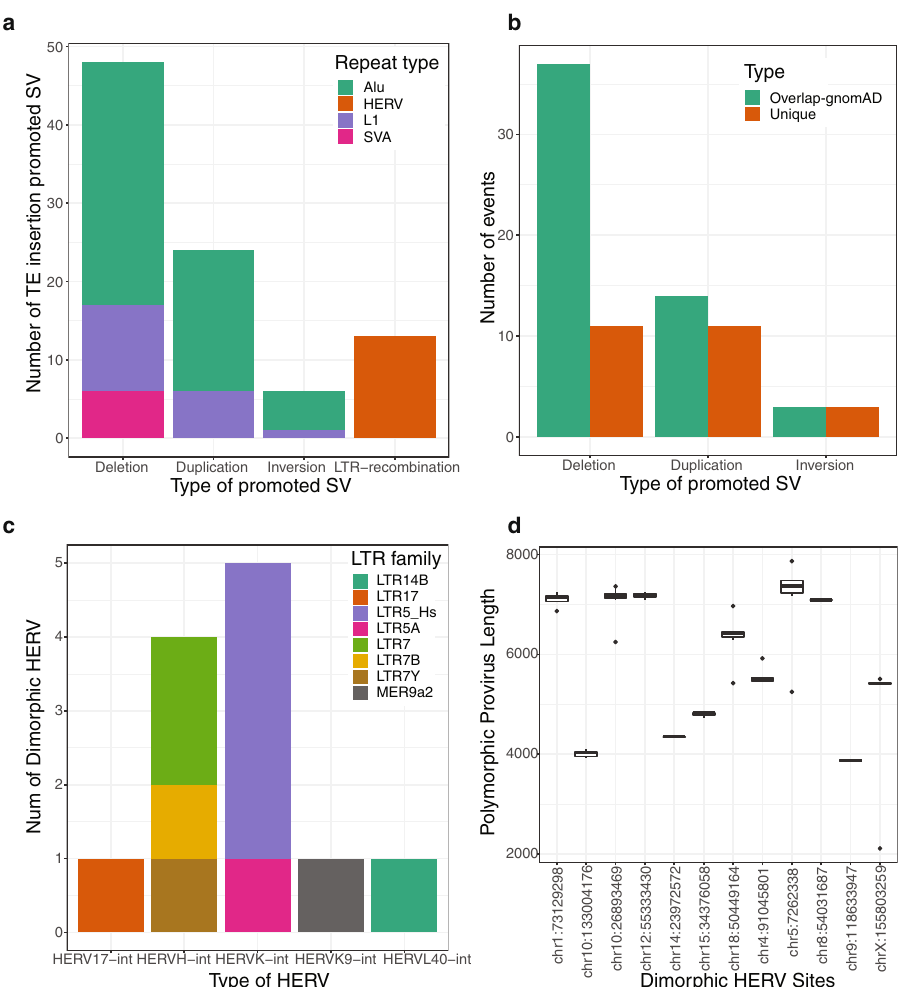
Fig. 5 Structural variants mediated by TE insertions. a xTea called out several structural variants promoted by insertions of different types of TEs from the 20 long-read samples: 48 (31 Alu, 11 L1, and 6 SVA) deletions, 24 (18 Alu and 6 L1) duplications, and 6 (5 Alu and 1 L1) inversions. In addition, xTea called out 12 LTR recombination-caused dimorphic HERV events. b Compared to gnomAD-SV, more than 15, 40, and 50% of the TE-mediated deletions, duplications and inversions are novel. Each of these complex SVs are only called as one type of simple events, although the breakpoint positions are the or close to each other. c 6 HERV-K, 4 HERV-H, 1 HERV-L, and 1 HERV-W dimorphic HERV events are called out. Compared to a previously reported call set, 50% of the HERV events are novel. d Internal deletions occur in some dimorphic HERV insertions. Boxplot of each site shows the length of the HERV copy among different samples. While some copies are of full length (~7200 bp), some copies are only ~4000 bp although the front and tail parts exist. For the boxplots, the box demarcations represent the 25, 50, and 75th percentiles, and the whiskers extend from the box to the largest and smallest data points at most 1.5 times the interquartile range away from the